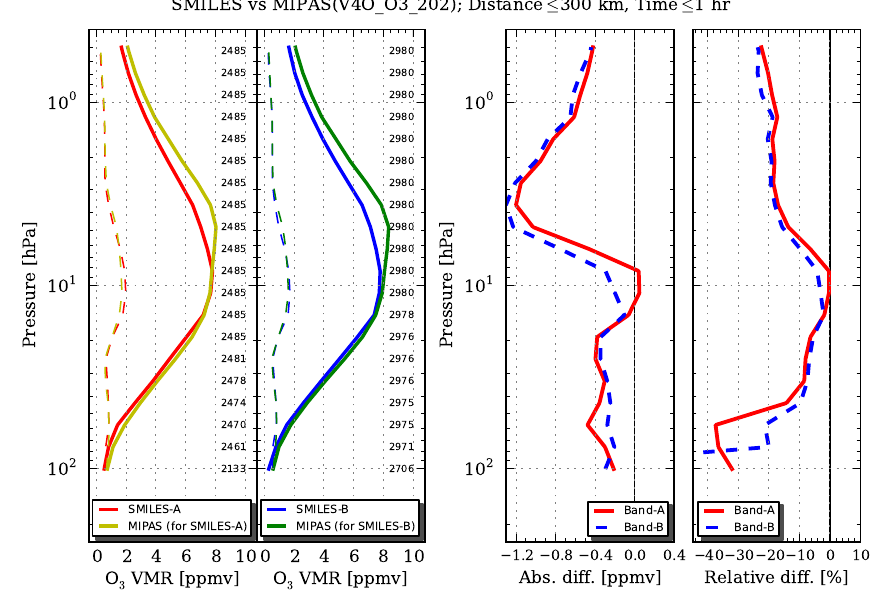
Fig. 17. Comparison between SMILES and MIPAS V4O_O3_202 O 3 profiles. See Fig. 12 for the plot format. generated by Institut für Meteorologie und Klimaforschung (IMK) at Karlsruhe Institute of Technology (KIT) (von Clar- mann et al., 2009). This data product was retrieved using (Steck and von Clarmann,